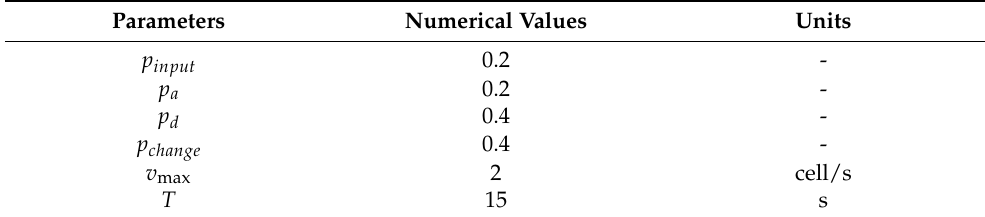
Table 4. Experimental parameters of cellular automata simulation model.